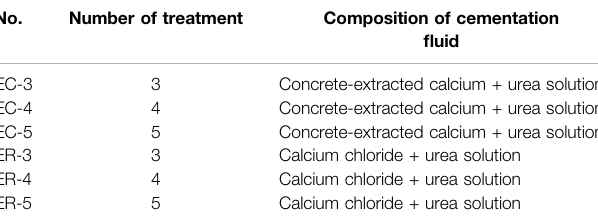
TABLE 1 | Sand sample parameters of different in fl uencing